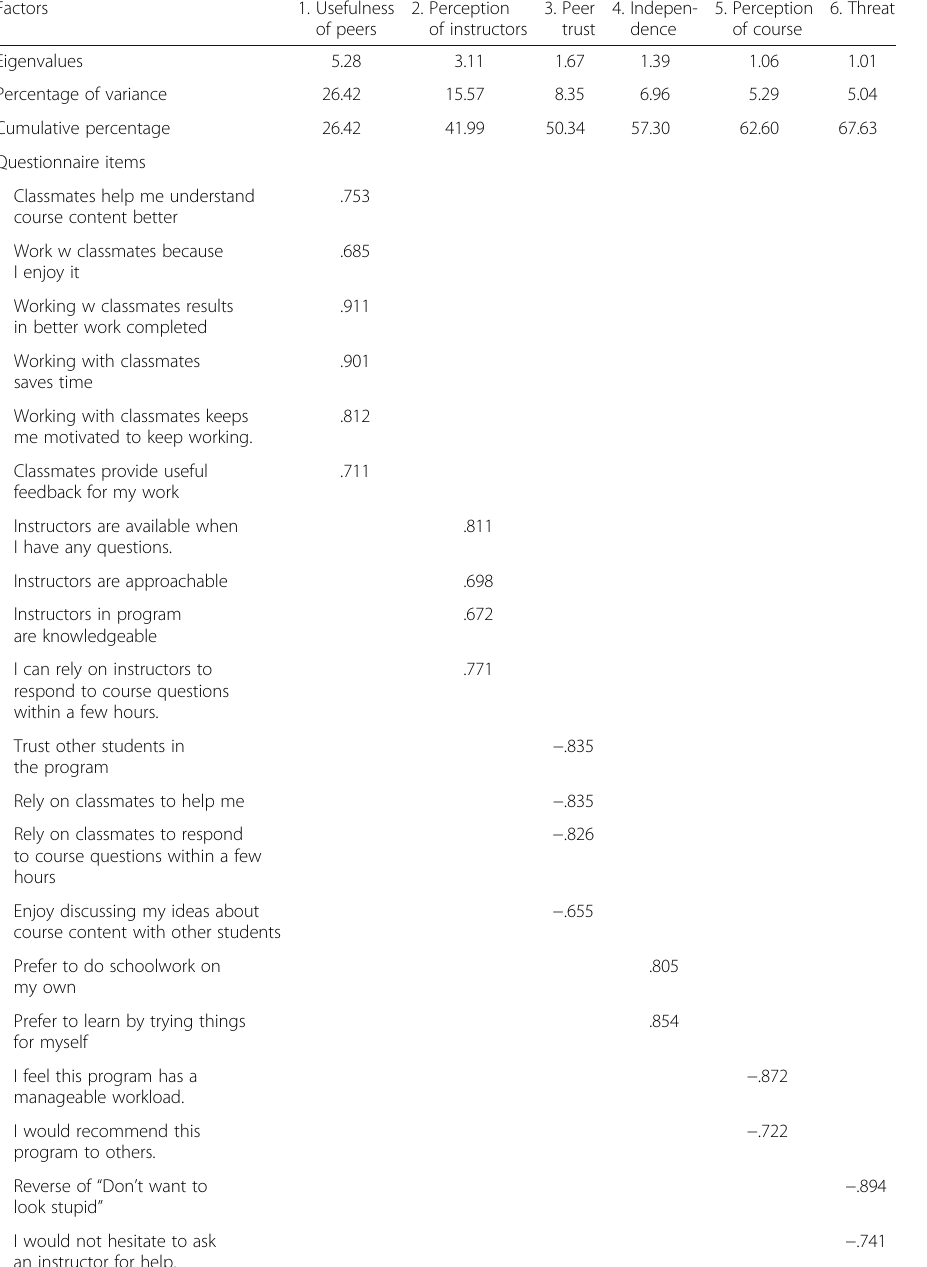
Table 2 Pattern matrix a of attitudinal variables